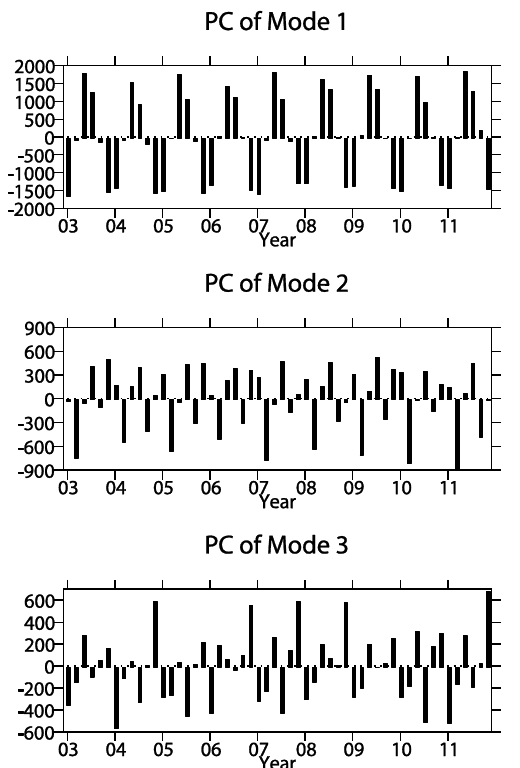
Figure 3. Time series of first three PCs in the period of 2003-2011. 409 Fig. 3. Time series of first three PCs in the period of 2003–2011.